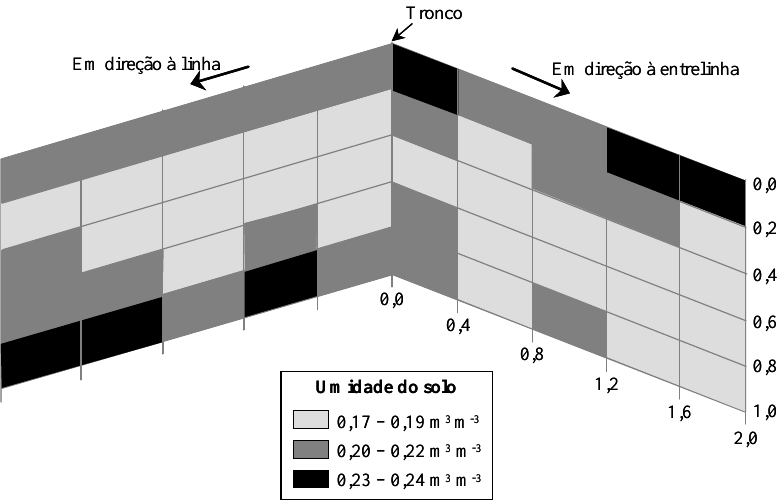
Figura 3. Perfis de umidade ( qqqqq versus z) para as várias distâncias do tronco, em direção à linha e em direção à entrelinha durante o período